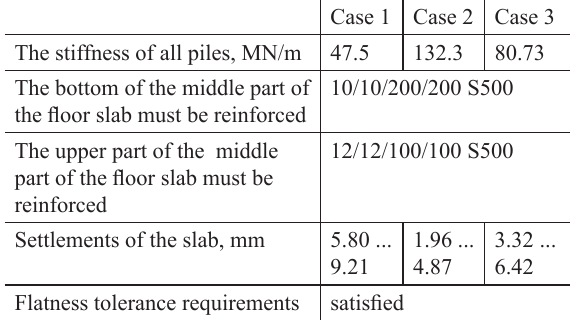
Table 10. Comparison of calculation results